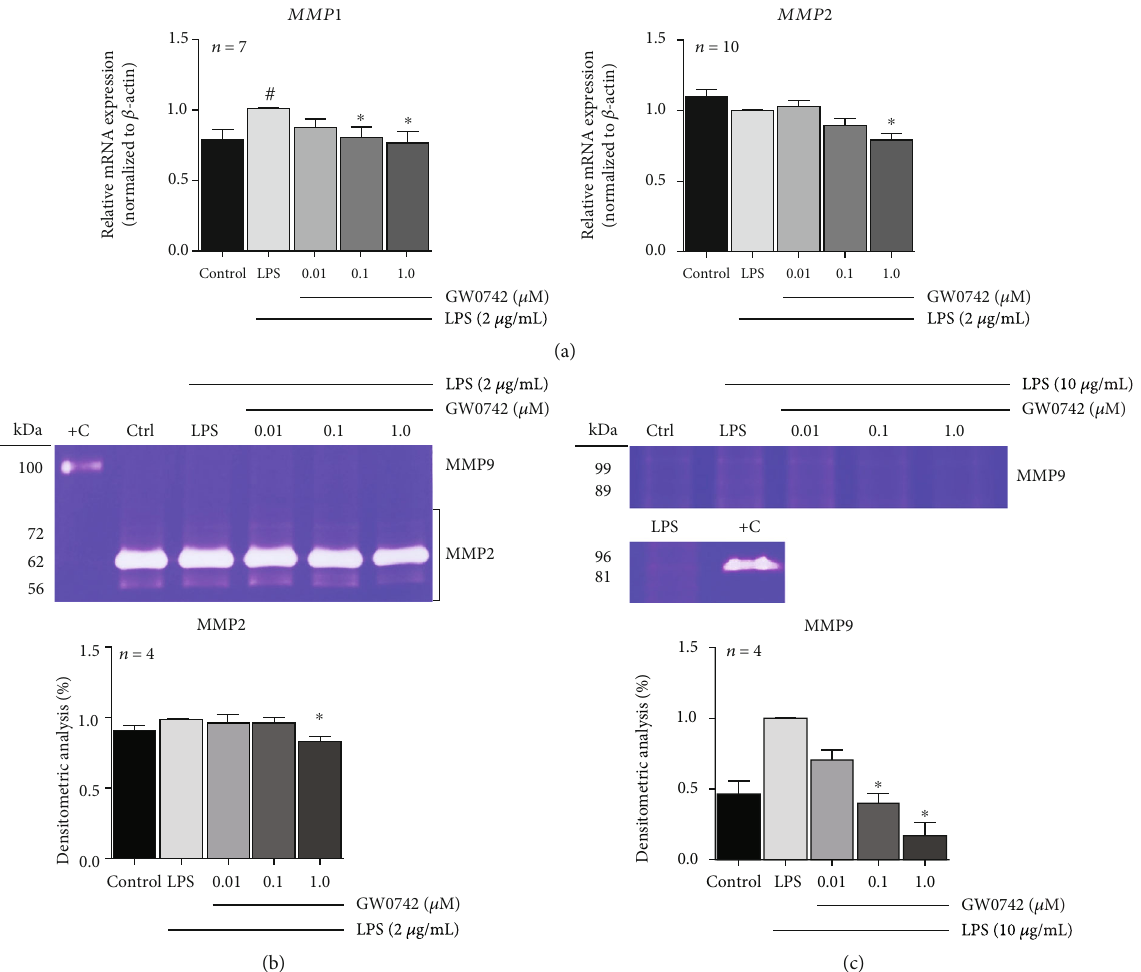
Figure 3: GW0742-activated PPAR β / δ represses MMP gene expression and gelatinolytic activity: (a) pretreatment with GW0742 repressed MMP1 and MMP2 gene expression and gelatinolytic activity of (b) MMP2 and (c) MMP9 in LSP-stimulated hDPCs ( p < 0 : 05 ; # vs. control; ∗ vs. LPS by Kruskal – Wallis and post hoc Dunn ’ s test; mean ± S : E : M : n = per group ). Control = DMSO0 : 1 % . +C = positive control , supernatant from macrophage RAW264.7